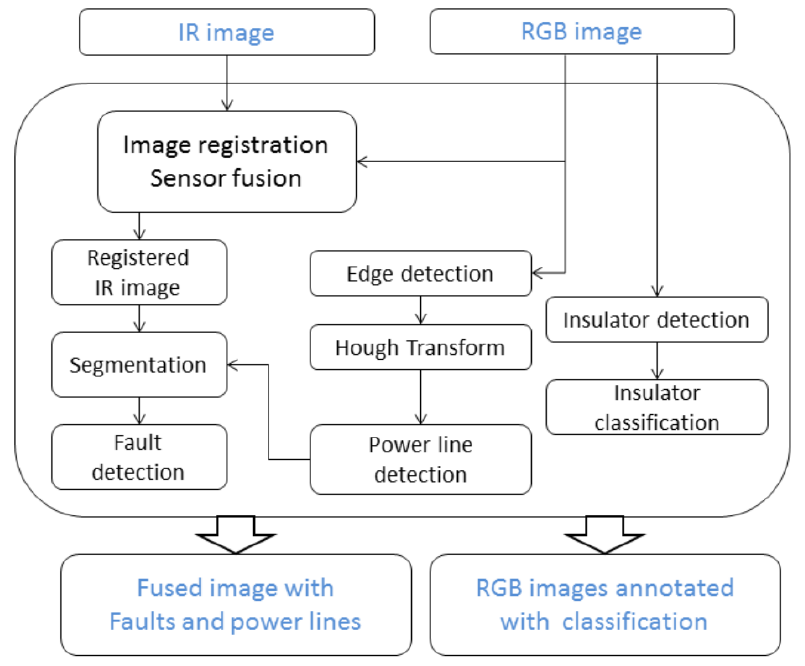
Figure 2. The processing